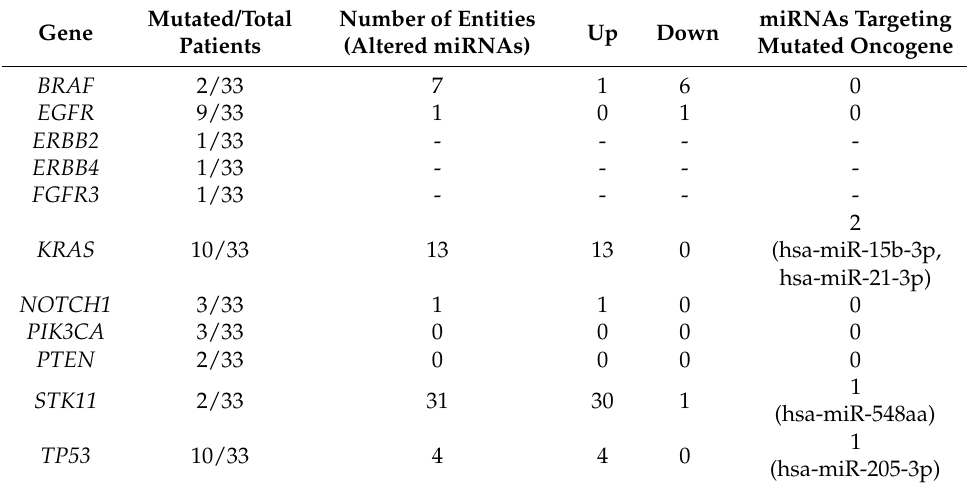
Table 2. A number of miRNAs significantly changed their expression according to the mutational status of each oncogene. This table lists the number of these miRNAs in patients carrying onco- gene mutations. Mutated/Total Number of Gene Patients